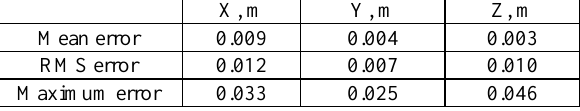
Table 2. Relative accuracy estimation of MLS data adjustment